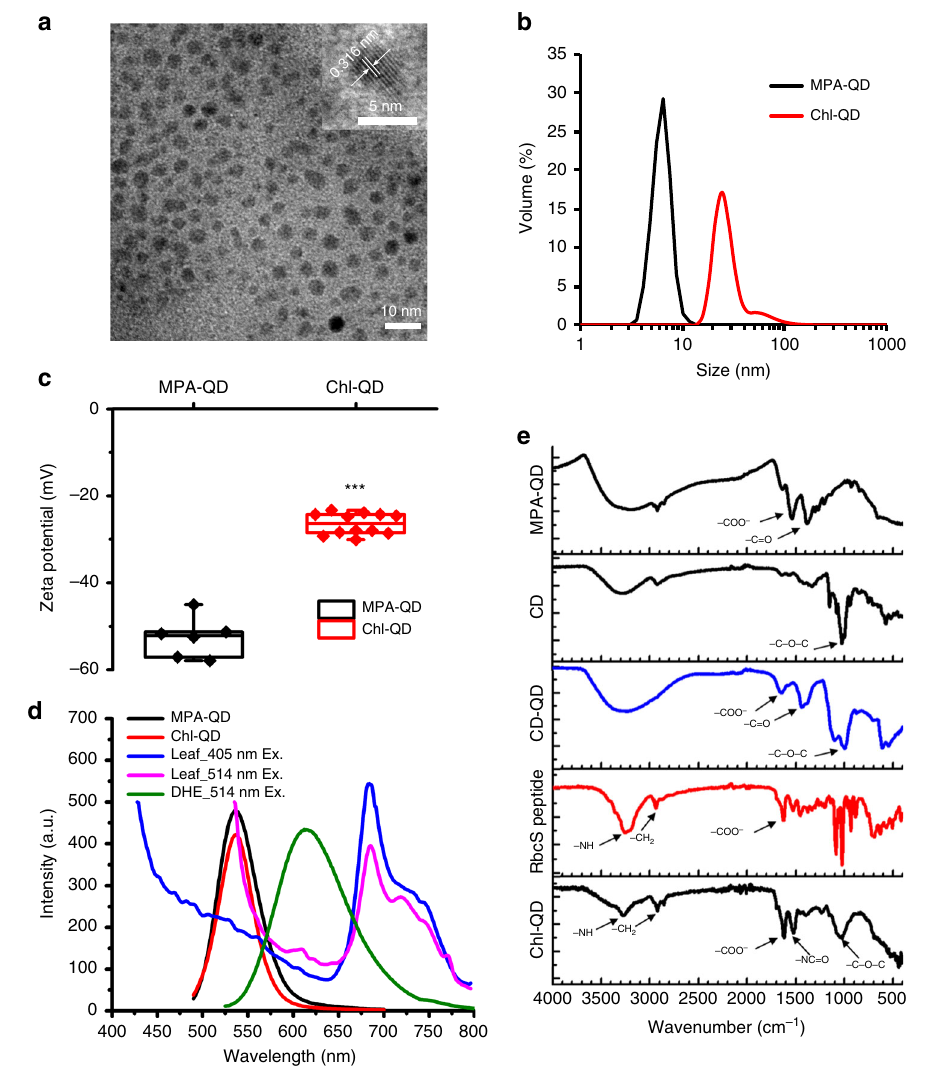
Fig. 2 Design and characterization of multifunctional quantum dots with chloroplast guiding peptide. a Representative transmission electron microscopy image of MPA-QD showing the average diameter of the QD nanoparticle core of 4.3 ± 0.2 nm ( n = 3). b Hydrodynamic diameter measured by DLS (pH 7) of MPA-QD (6.1 ± 0.5 nm, n = 4) and Chl-QD (24.5 ± 2.5 nm, n = 5). Values are means and ± indicates standard deviation. c High zeta potential of MPA-QD ( − 52.6 ± 4.7 mV, n = 6) and Chl-QD ( − 28.4 ± 3.8 mV, n = 17) that allows penetration through lipid bilayers in the cell membrane and chloroplasts. Box plot error bars represent standard deviation, boxes are the interquartile range from the fi rst to the third quartile, and horizontal line represents the mean. Statistical comparison was performed by independent samples t -test (two tailed). *** indicates P < 0.001. d Fluorescence emission spectra of MPA-QD and Chl-QD in the range of low background fl uorescence emission from leaves. e FTIR spectra of MPA-QD, β -cyclodextrin ( β -CD) coated QD (CD-QD) and Chl-QD indicating successful functionalization of QD with β -CD and guiding